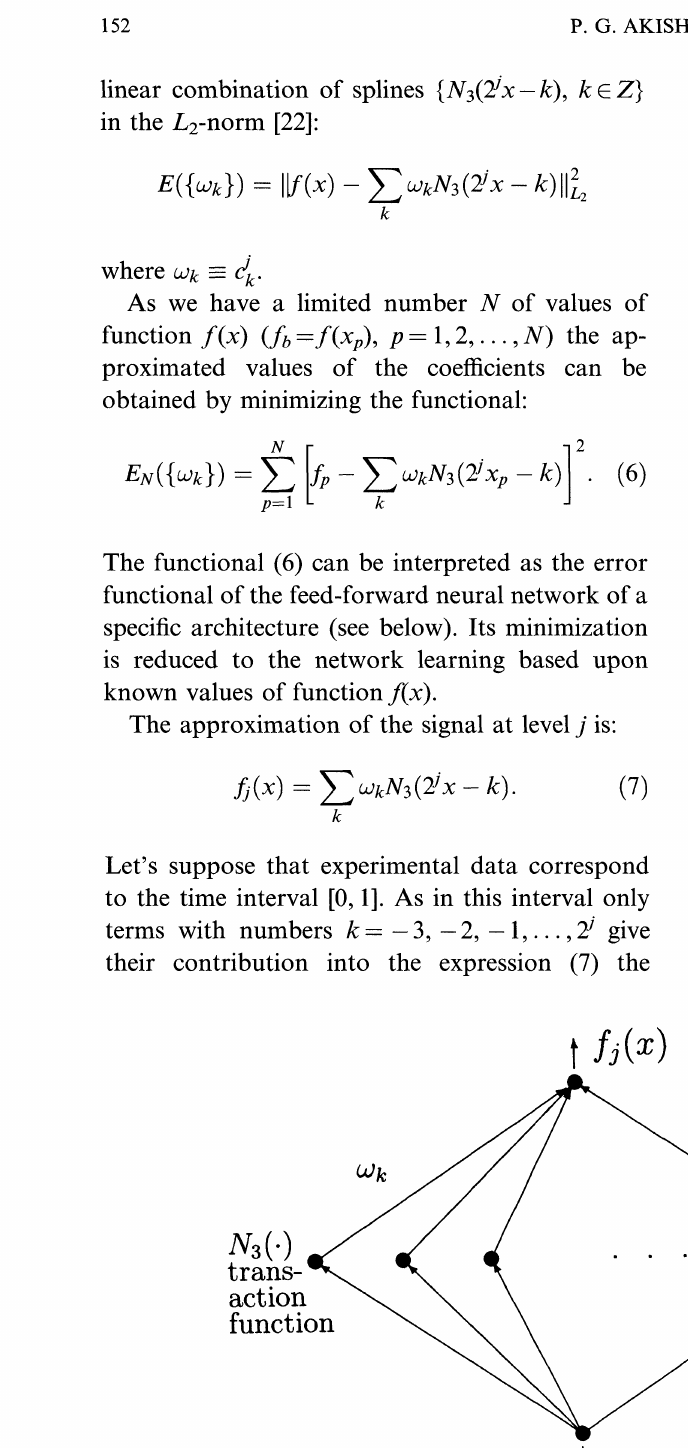
FIGURE 6 The architecture of the WNN neural